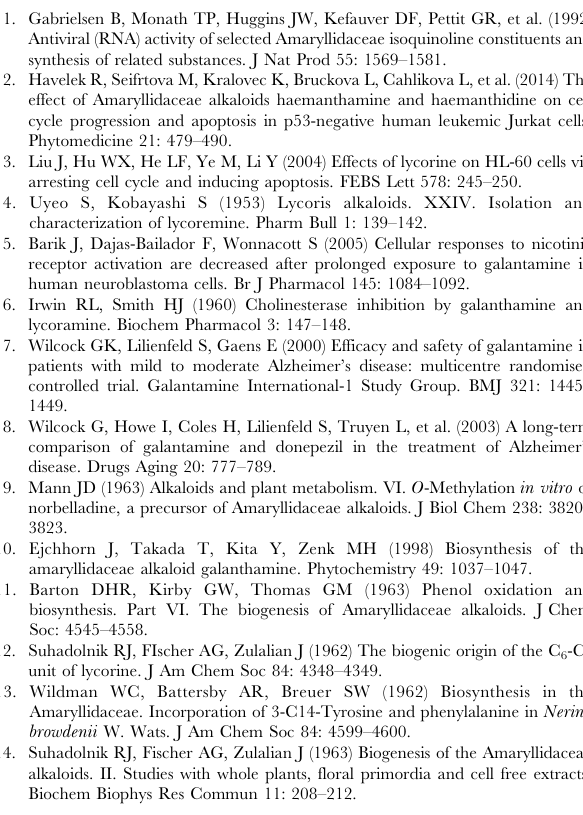
Table S1 Methyltransferases used in BLAST search. Table S2 Methyltransferases used in phylogeny. Table S3 Primers used in RACE, cloning and colony PCR. Table S4 Parameters used for LC/MS/MS